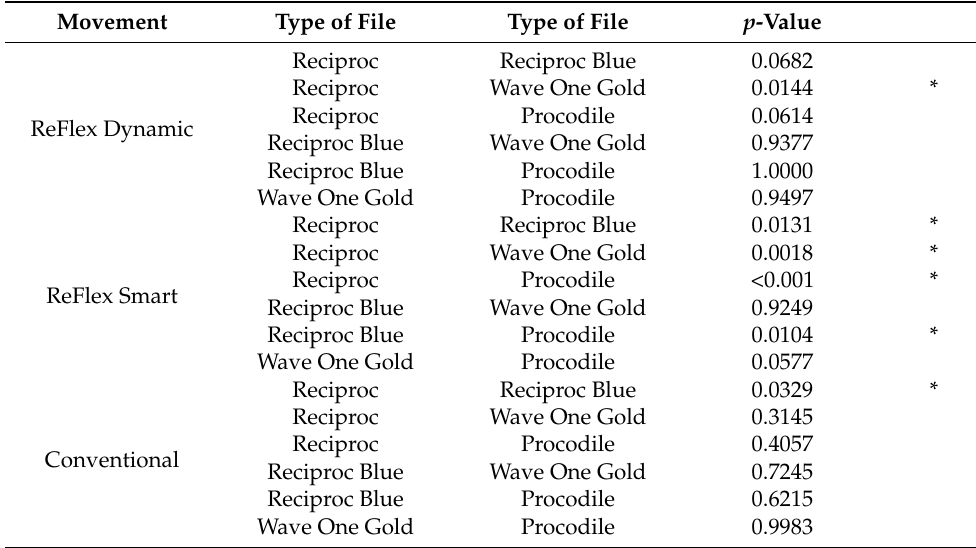
Table 4. Two-to-two comparison between different types of files with the same movement (* = p value < 0.05).